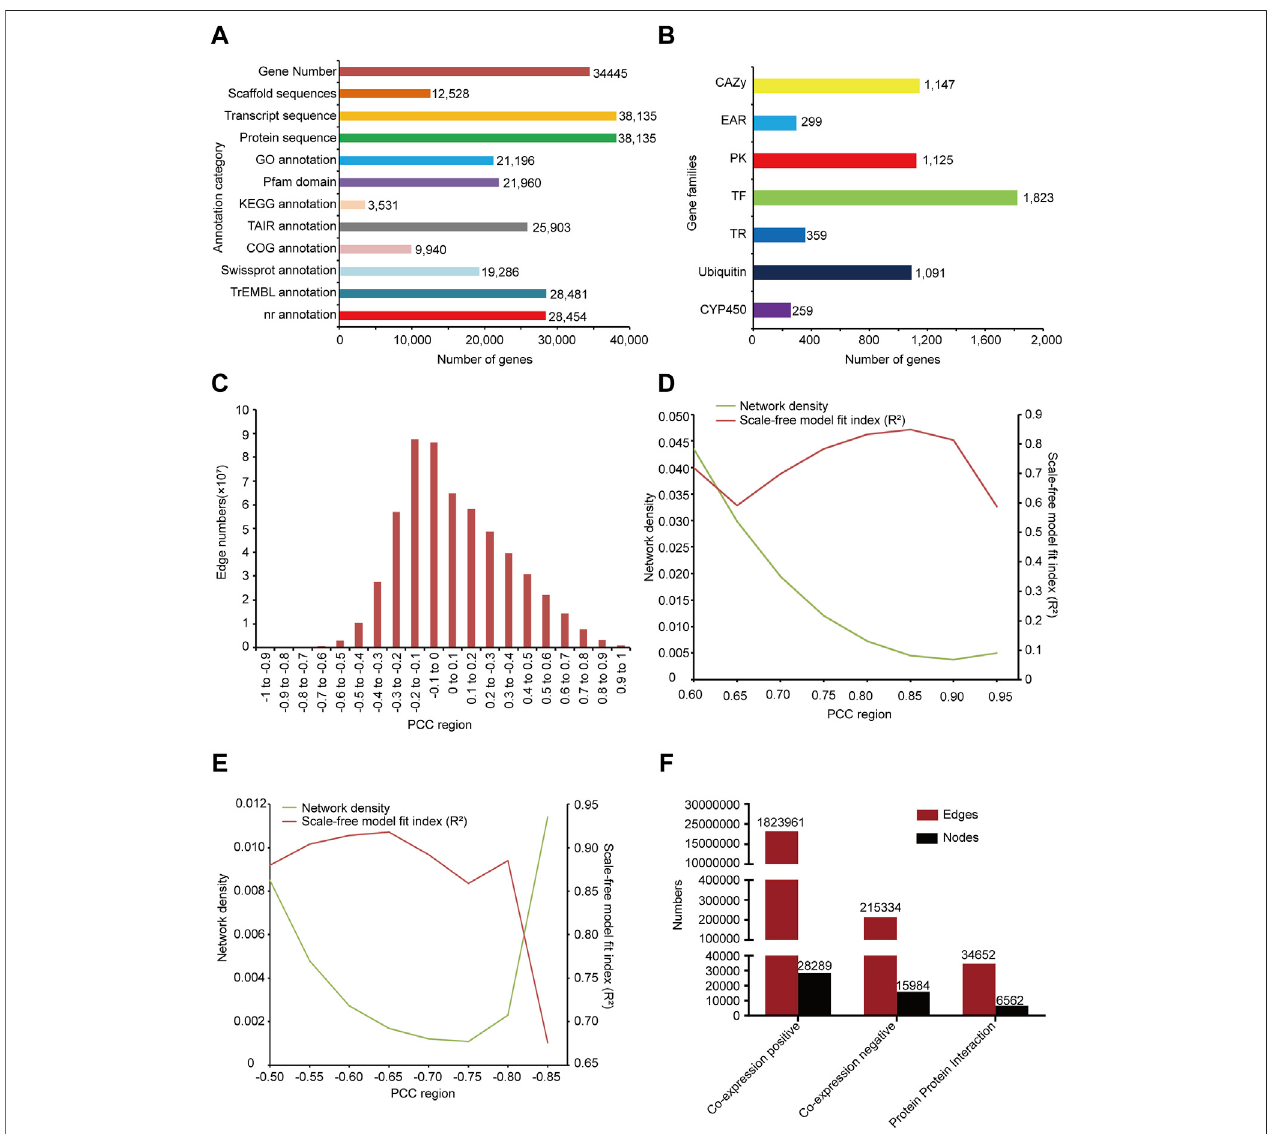
FIGURE 1 | Overview of functional annotation and co-expression network constructed. (A) The number of sequences and annotated genes. (B) Classi fi cation of gene families and number of genes, including transcription factors (TFs), transcription regulators (TRs), protein kinases (PKs), EAR motif-containing proteins (EARs), cytochrome P450 (CYP450), Carbohydrate-Active enzymes (CAZys) and Ubiquitin proteases. (C) The diagram distributions of the gene-pairs as PCC changing. (D) Network density and scale-free model fi t (R 2 ) distribution in the positive co-expression network according to changing PCC. (E) Network density and scale-free model fi t (R 2 ) distribution in the negative co-expression network according to changing PCC. (F) Statistics of nodes and edges in the positive co-expression network, negative co-expression network, and PPI network.